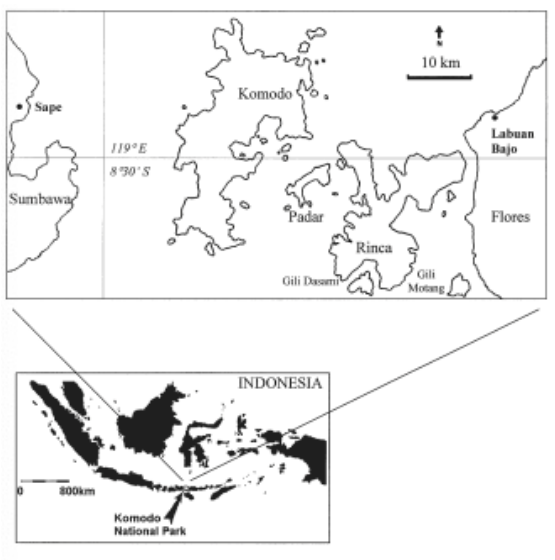
Source : Walpole and Harold